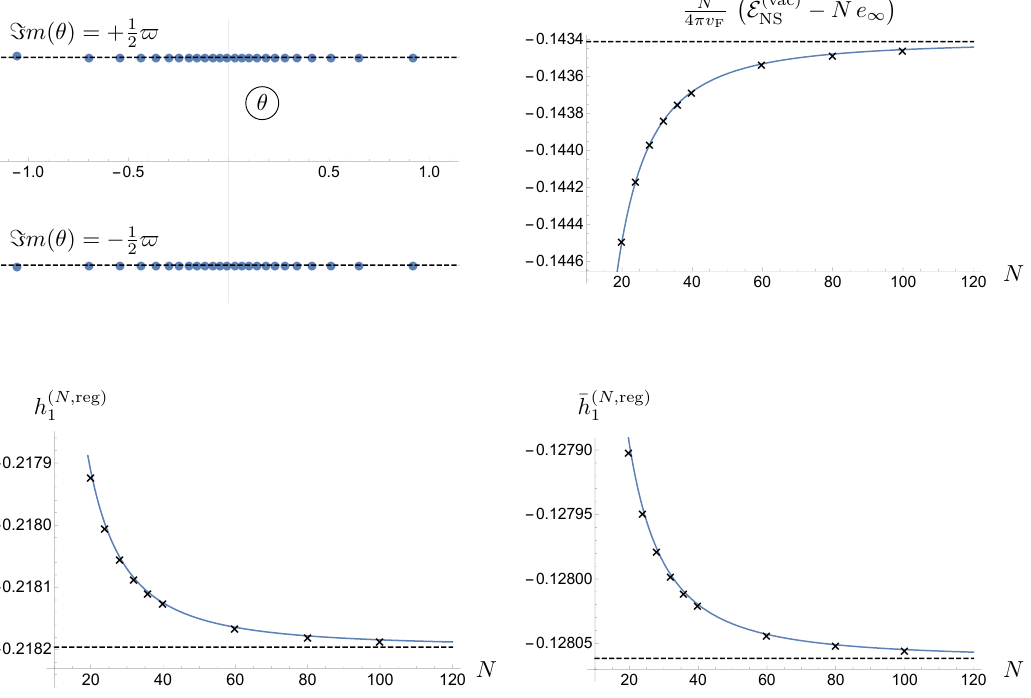
Figure 2 . Numerical data for the ground state of the Hamiltonian H (12.19) for even N/ 2 and S z = 0 . The top left panel depicts the pattern of Bethe roots in the complex θ plane with θ = − 1 log( ζ ) ( N = 100 ). The top right panel concerns the ground state energy E (vac) 2 crosses were obtained through the solution of the Bethe ansatz equations for increasing N , while the blue solid line represents the fit − 0 . 14341 − 0 . 43286 /N 2 . The limiting value, as predicted by eq. (12.45), is marked by the dashed black line. The bottom two panels illustrate the sum rules (12.38) and (12.40). The superscript “ reg ” indicates that a subtraction and rescaling has been made, which makes the limit N → ∞ well defined, e.g., h ( N, reg) Again, the crosses stand for the numerical values, which were found by solving the Bethe ansatz equations, while the solid blue line is a fit, − 0 . 21820 + 0 . 11285 /N 2 and − 0 . 12806 + 0 . 06623 /N 2 for the bottom left and bottom right panels, respectively. The dashed line represents the limiting value according to eqs. (12.38) and (12.40). For the eigenvalue of the first non-local IM on the primary states, see (9.61) and (9.62). The parameters were taken to be β 2 = 0 . 43 , k = 0 . 1 and $ = 1 . 3 . with α ( x ) from (B.9). Comparing the above with eq. (12.28) one finds 0